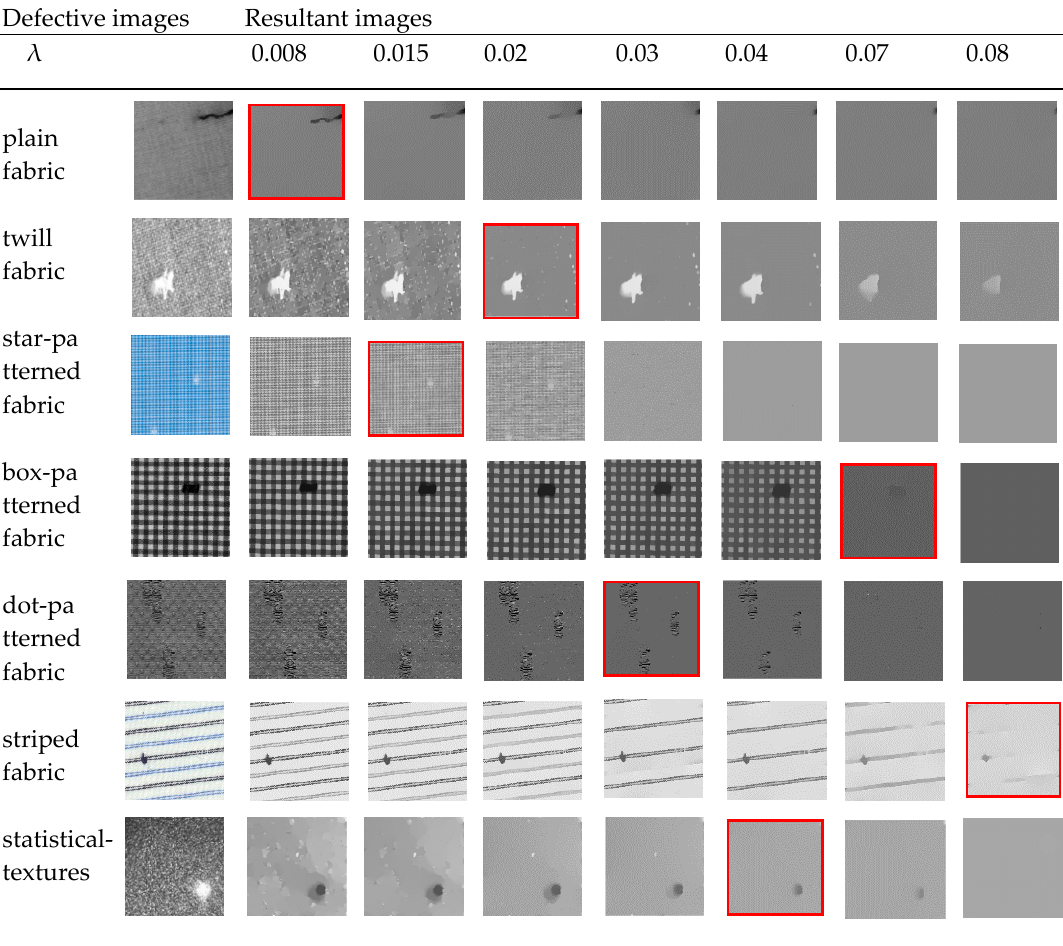
Figure 7. The optimum parameters about various fabric types.